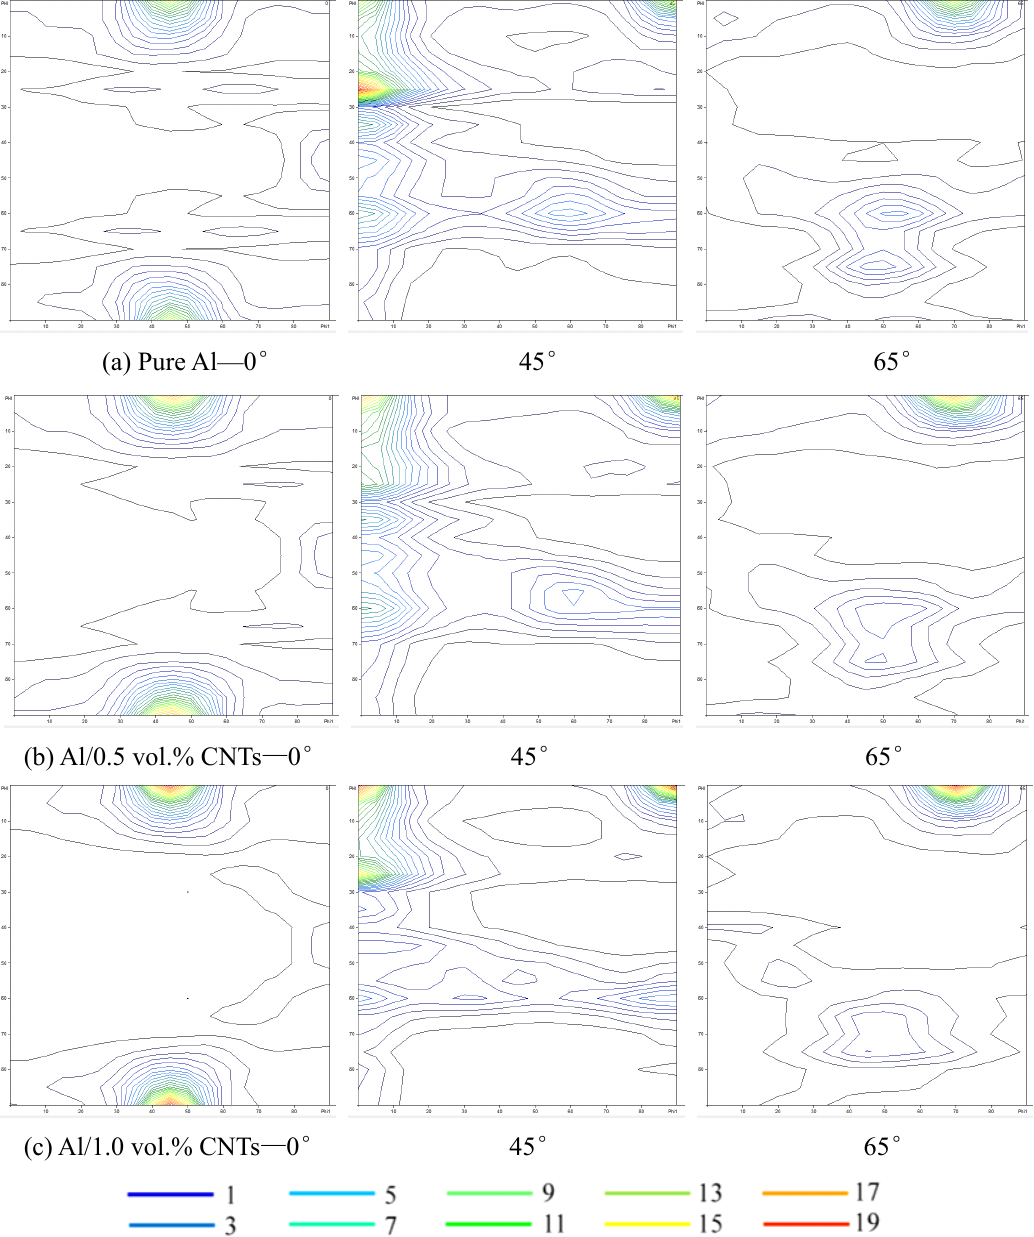
Figure 7. The orientation distribution functions (ODFs) ( ϕ 2 = 0 ◦ , 45 ◦ , and 65 ◦ sections) for rolling textures of the pure Al ( a ) and Al/CNTs nanocomposites with 0.5 ( b ) and 1.0 ( c ) vol.% CNTs after 12 ARB cycles